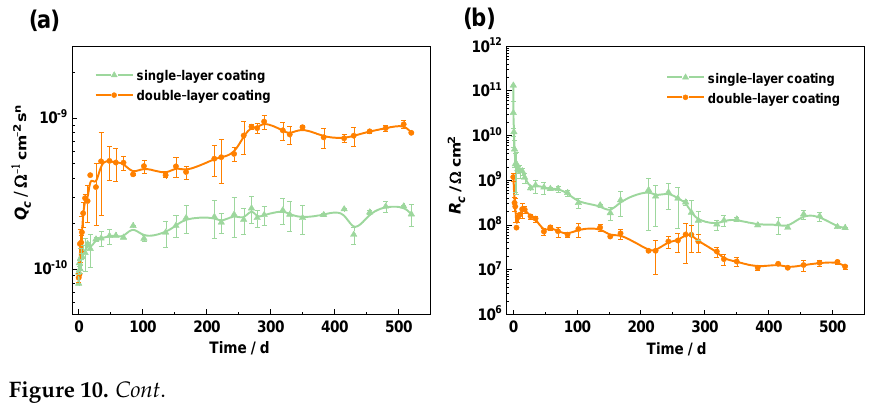
Time / d Figure 10. Fitting parameters for two coating samples: ( a ) Q c ; ( b ) R c ; ( c ) Q dl ; ( d ) R ct ; ( e ) Q ox ; ( f ) R ox . 3.4. Cerium Release of the Epoxy Coating Figure 11 shows the cerium ions release result from the epoxy coating containing 5 wt% CeTar by ICP-MS measurement. Figure 11a shows the amount of cerium ions in the solution detected at different times. After 6 d immersion, the concentration of cerium ions quickly increases to 0.68 μg/(mL ·cm 2 ), and then increases to be slightly slower, which in- dicates that cerium ions are continuously released form the coating. Figure 11b shows the calculated releasing rate of cerium ions. In the beginning, the cerium ions releasing rate is 0.5 μg/(mL∙d∙ cm 2 ) and then quickly decreases with time. After 7 d, the release rate de- creases to 0.01 μg/(mL∙d∙ cm 2 ) and then remains basically unchanged. This result is con- sistent with that in the literature [32]. Based on this, it can be inferred that cerium ions in the coating can also be released constantly towards the interface between the coating and